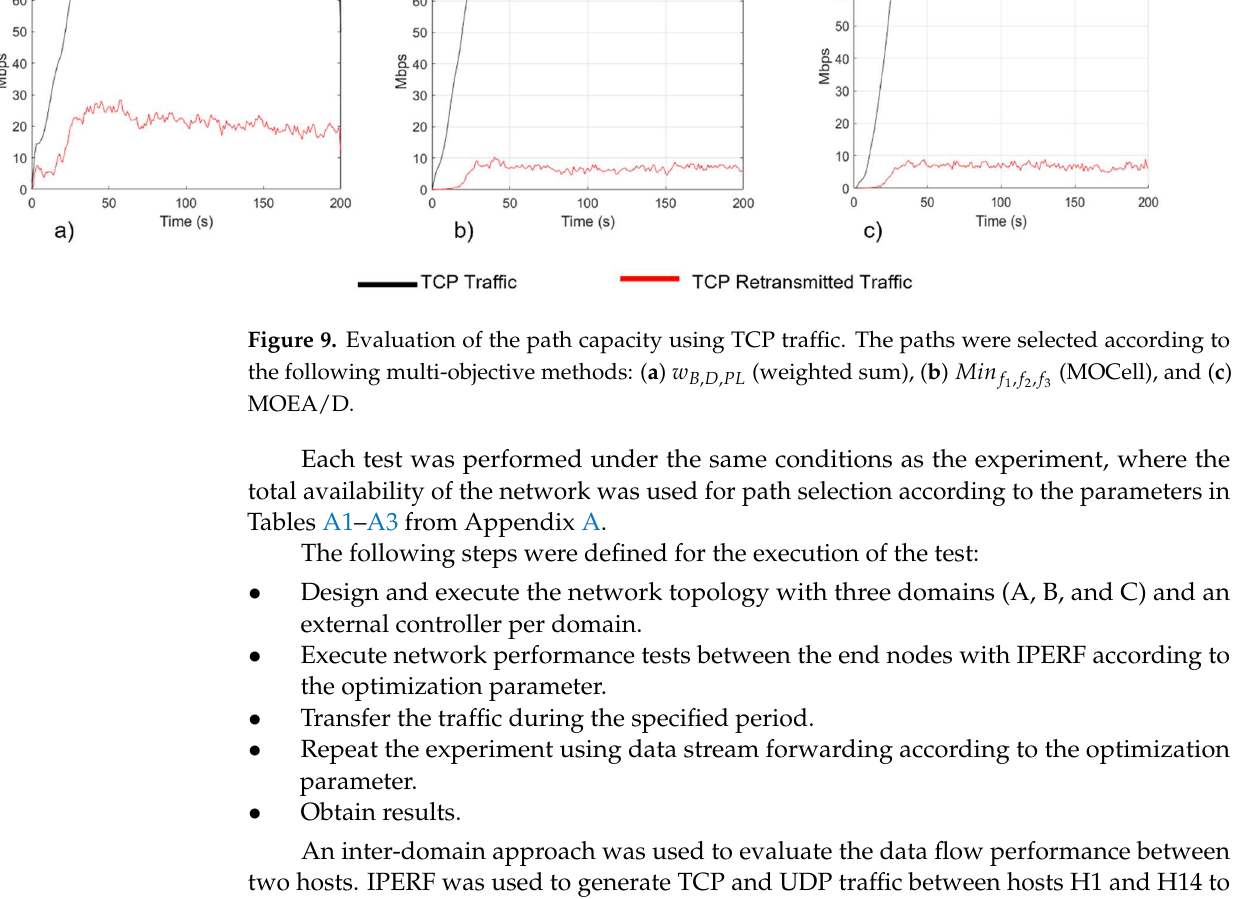
Figure 8. Evaluation of the path capacity using TCP traffic. The paths were selected according to the following methods: ( a ) 𝐻 (hops), ( b ) 𝐵 (bandwidth), ( c ) 𝐷 (delay), and ( d ) 𝑃𝐿 (packet loss).